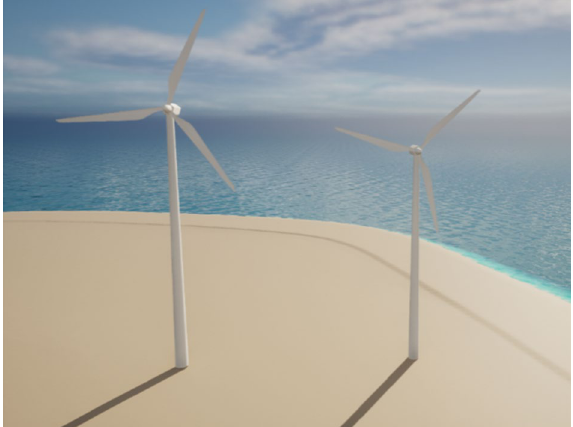
Fig. 6 Screenshot of the environment from the front